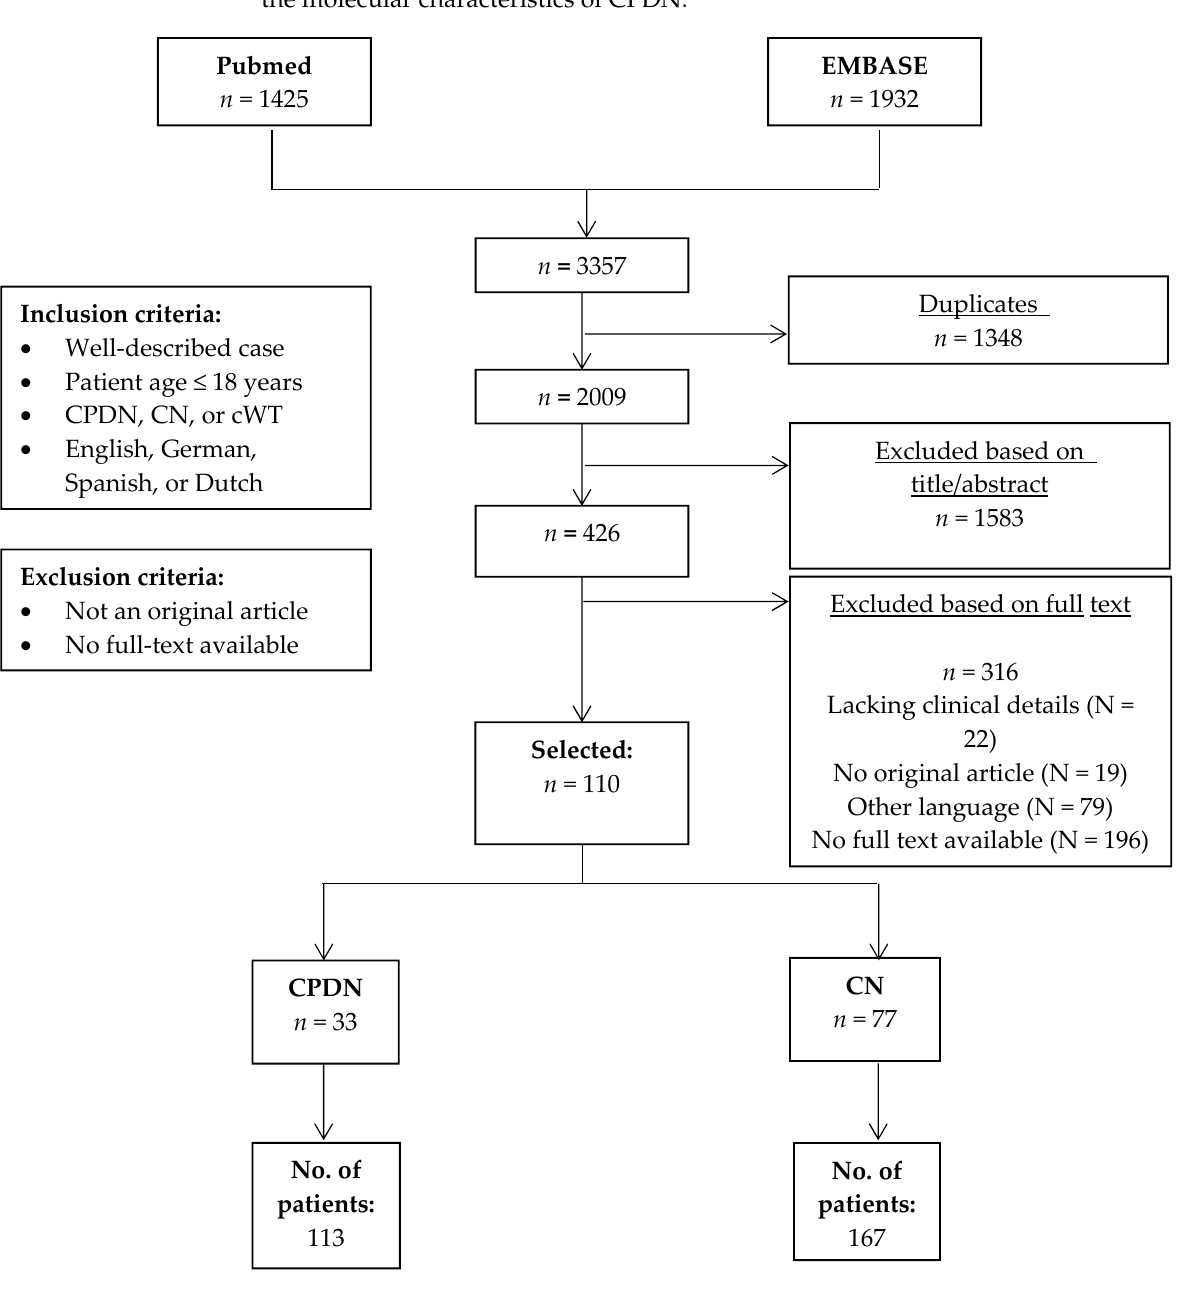
Figure 1. Flowchart of the literature search (updated 15 June 2020). n = number of reports. CN: cystic nephroma; CPDN: cystic partially differentiated nephroblastoma; cWT: cystic Wilms tumor